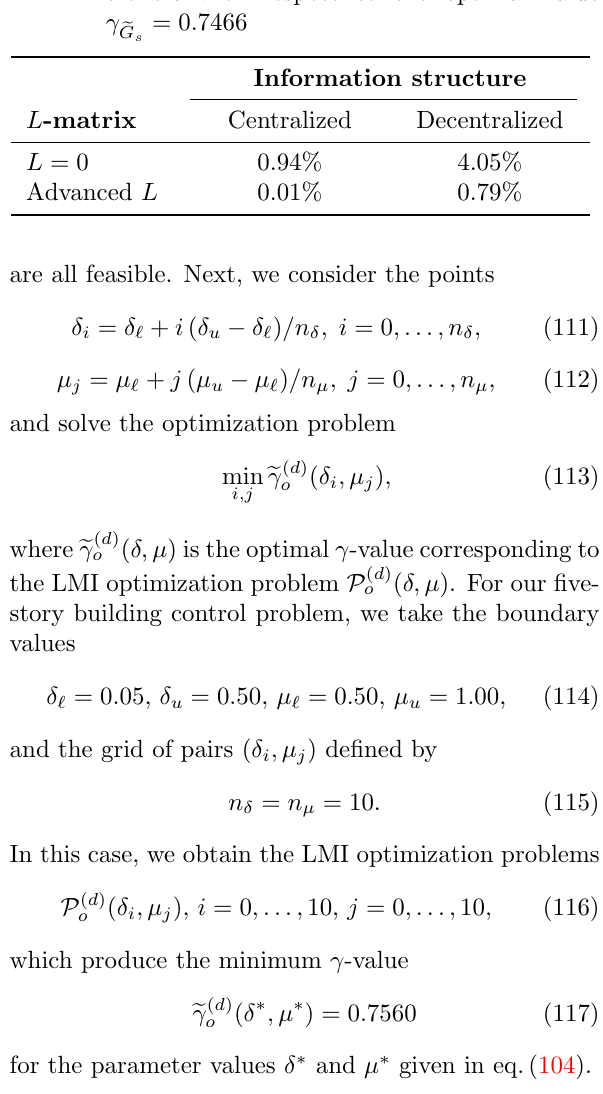
Table 1: Percentages of increment in the γ -values pro- duced by the static velocity-feedback con- trollers with respect to the optimal